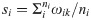
Mean scores according to scientific field.We compared the aggregate category scores, S, and assigned them to one of four fields based on the Student’s t-test. Pure and applied sciences includes physics, chemistry, materials, and engineering (S = 59). Natural sciences includes biology, geosciences, medicine, computer science, agricultural sciences, environment, statistics, and archeology (S = 54). Many humanities categories made up the third field (S = 48): psychology, management, mathematics, sociology, literature, education, and health. The final field (S = 41) comprised philosophy, political science, and law. The error bars depict 95% confidence intervals, ni is the number of responses per category, and si=Σiniωik/ni. (Symbol sizes are larger than most error bars).